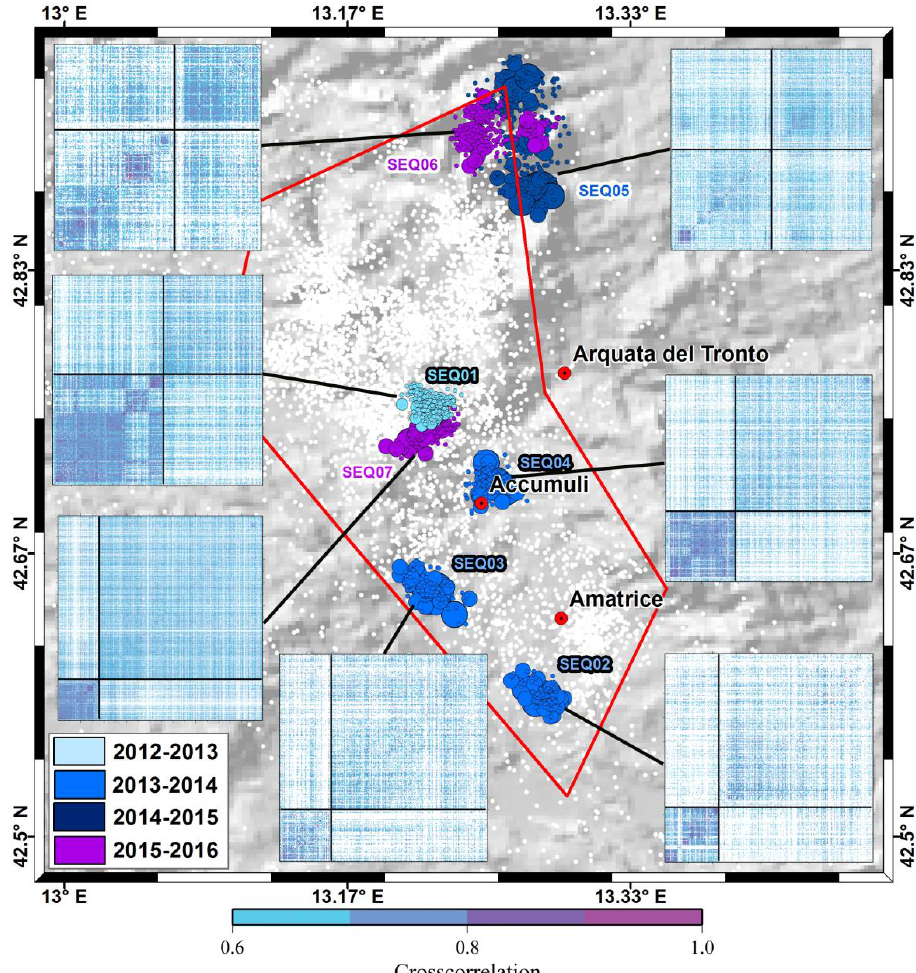
Figure 2. Clusters of seismicity in the source zone of Amatrice sequence. The cross-correlation coefficient matrix are show in the small panels. The seismicity clusters are colored following an annual time